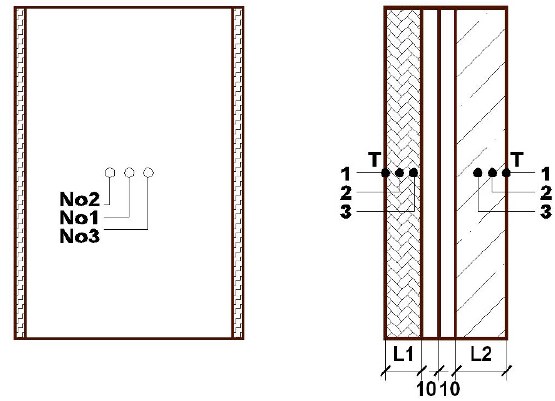
Figure 4. Temperature sensors inside the